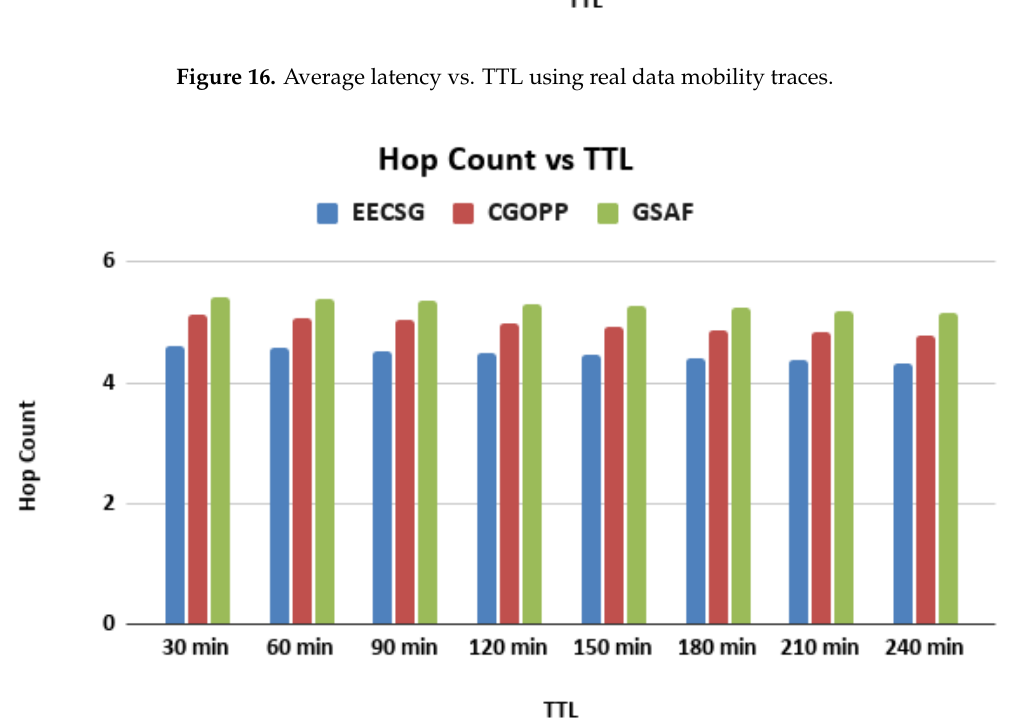
Figure 17. Hop count vs. TTL using real data mobility